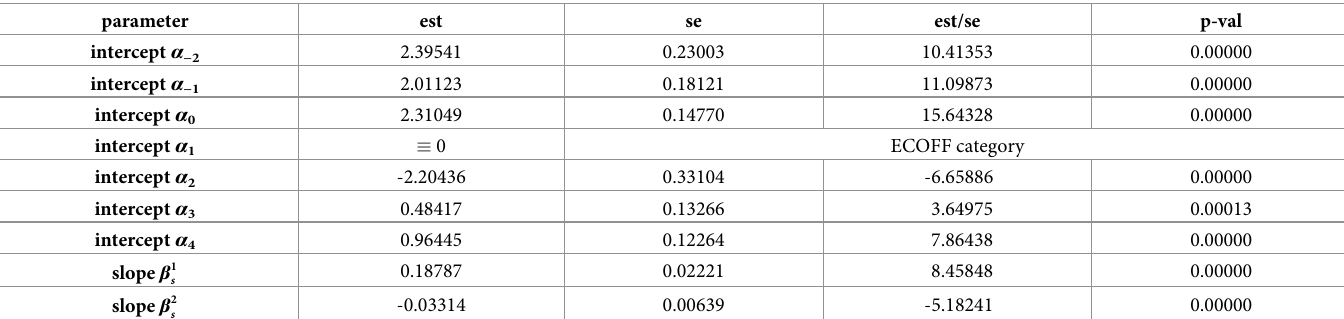
Table 8. The ISU VDL data: Parameter estimates of best fitting model 7.